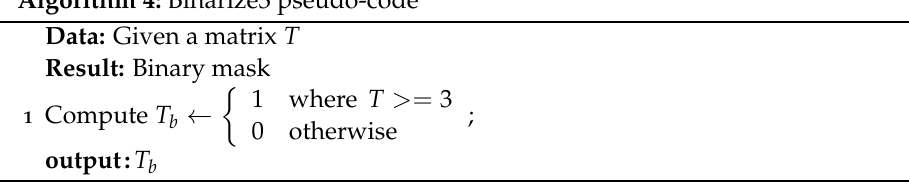
Algorithm 4: Binarize3